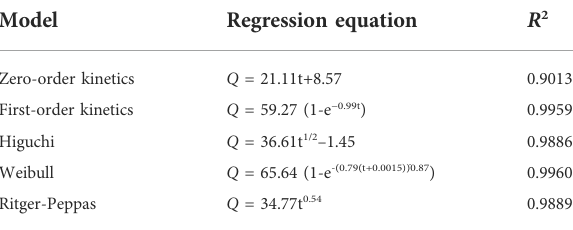
TABLE 3 The regression equation of the release pro fi le of FA from FaeA@sEVs-FA in vitro .